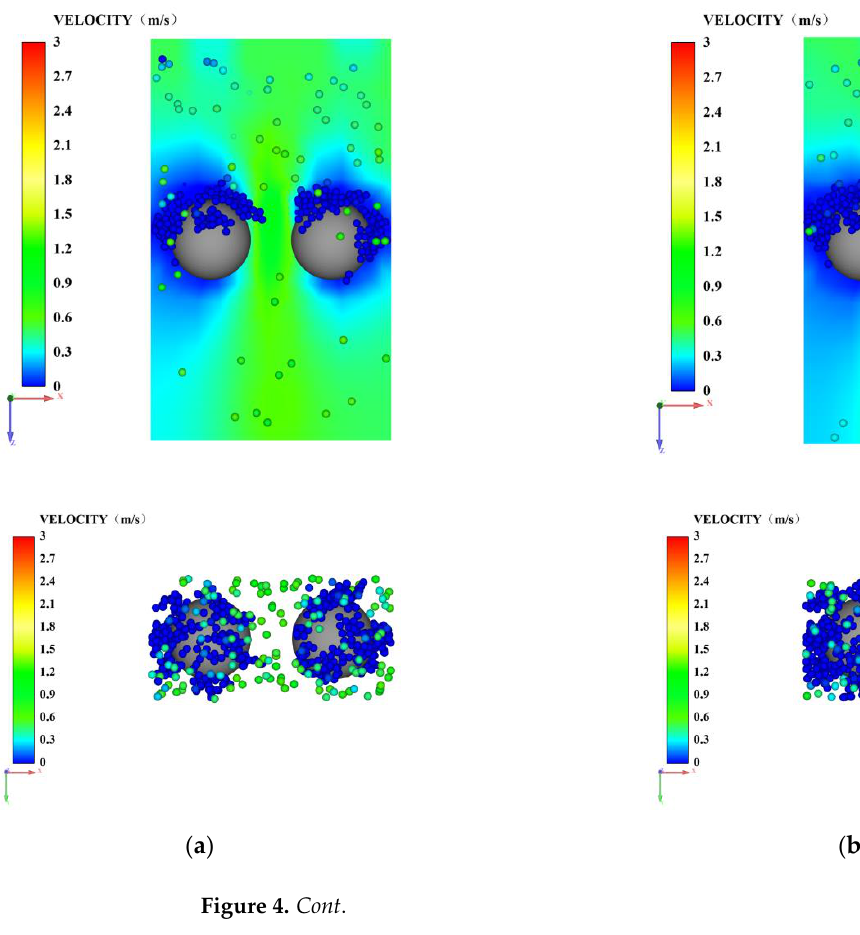
Figure 3. Differential pressure curve with time.